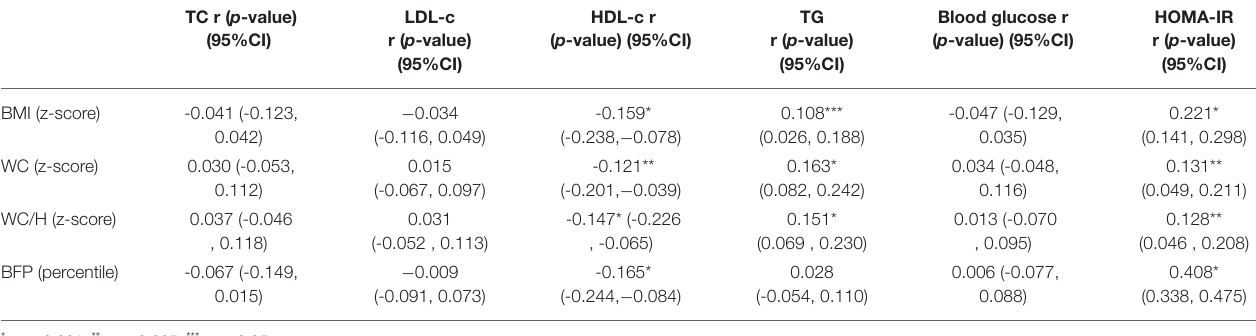
TABLE 1 | Correlation (r) between anthropometric indicators of excessive adiposity and serum biomarkers.